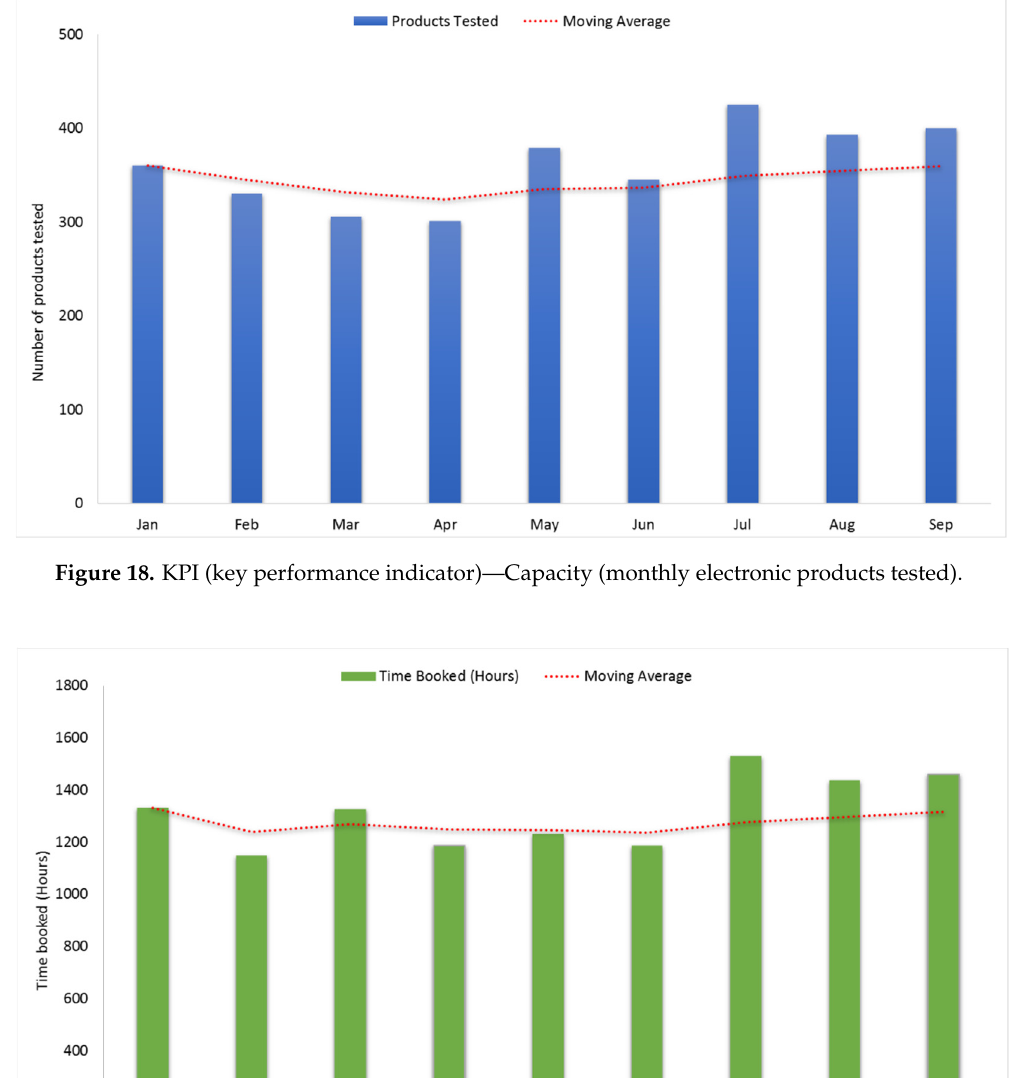
Figure 19. KPI—Capacity (monthly test time booked).